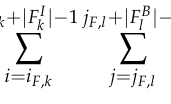
Figure 4. Decision variable x ij - item and bin